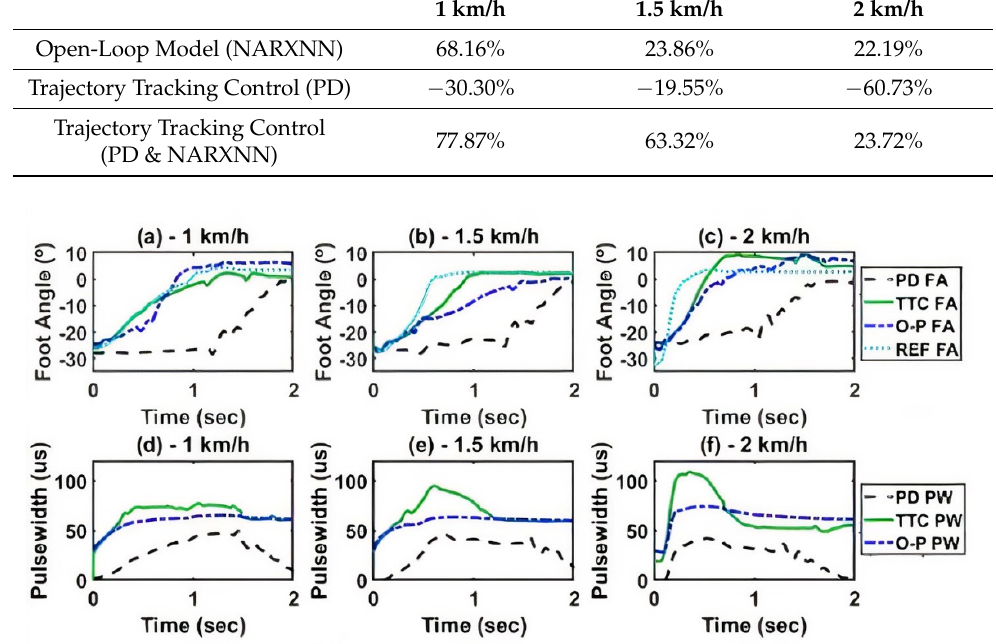
Table 2. Mean computation times obtained from the FES system operations.